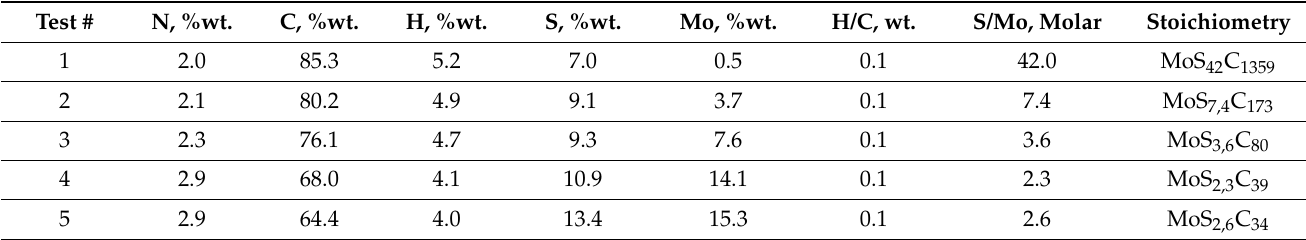
Table 4. Elemental composition of TI samples (normalized)